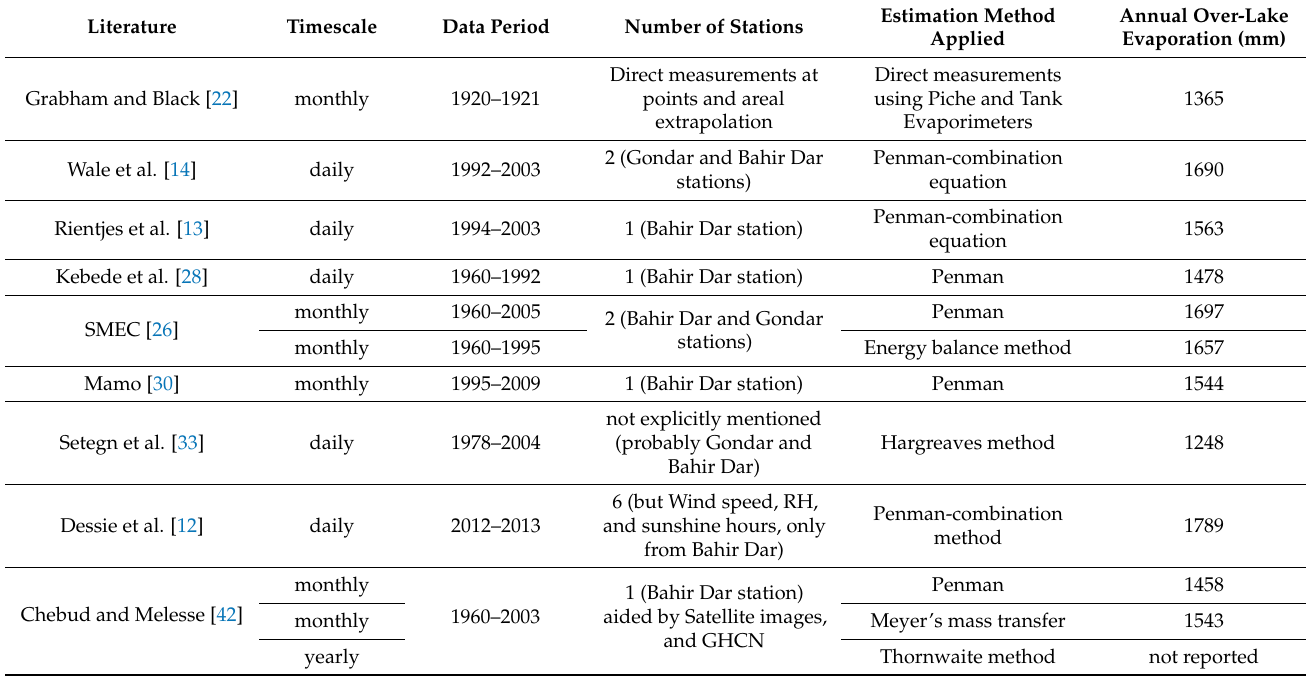
Table 2. Lake evaporation estimations made by different authors (applying different methods) for different periods and time